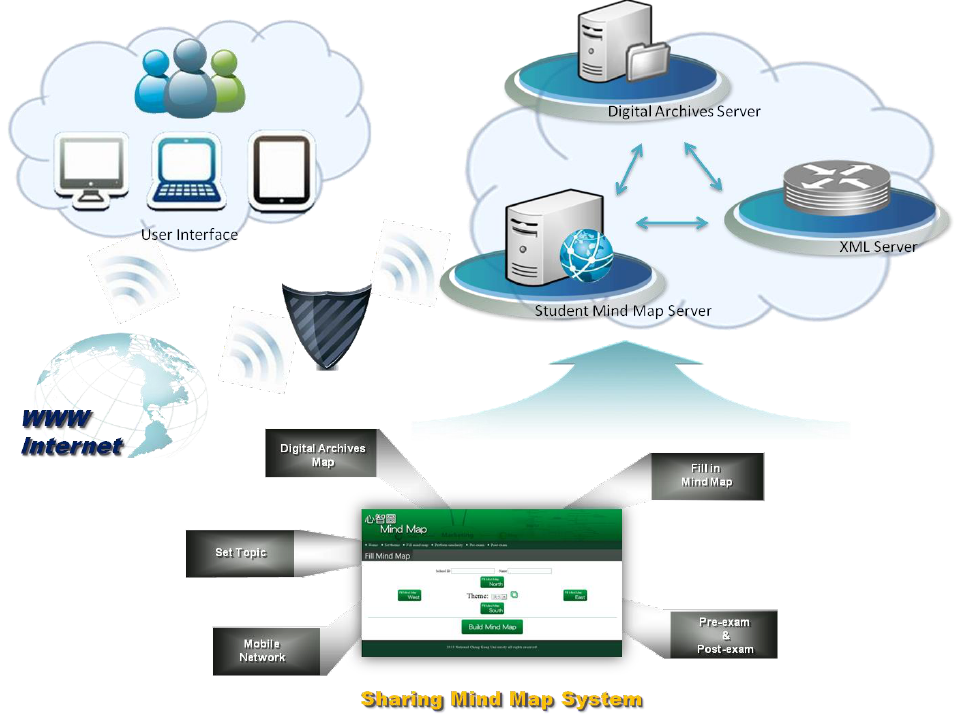
Figure 1 . Architecture of the sharing mind map for mobile collaborative learning systems. Sharing mind map system is written via HTML and JavaScript on mind map geography. The data are mainly saved as XML format. The XML file is shown as Appendix B. The framework is written based on PHP. The purpose of using these different languages is to enable the system to be used on diffetent platforms or any mobile devices to achieve mobile